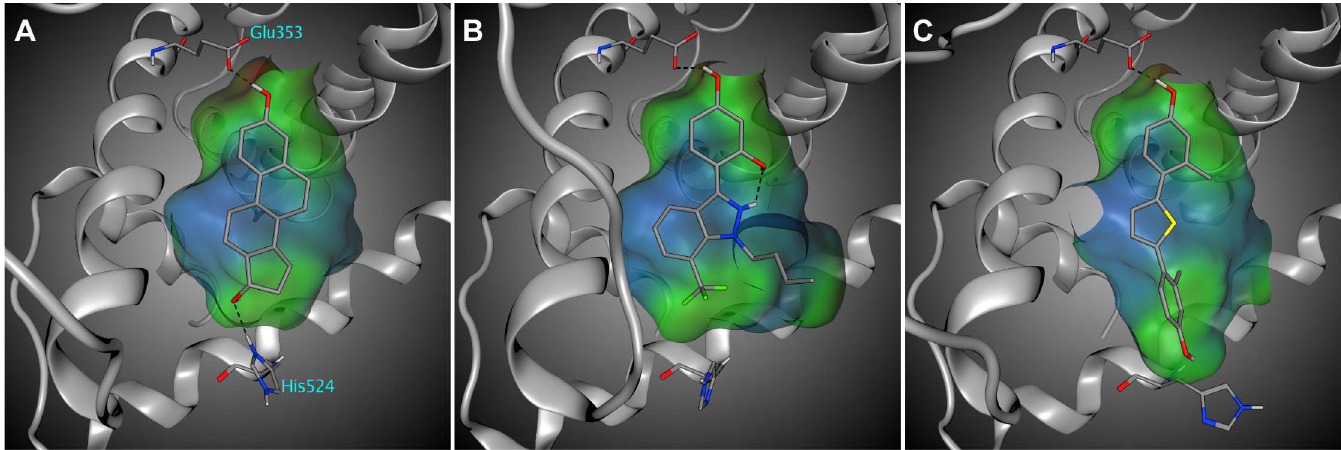
Fig 3. Classification of His524 conformations (PDB IDs: 2YJA, 4IVY, and 4IWC). Closed(A) and moved back (B) conformations which stabilizeprotein- ligandcomplex through hydrogenbondand hydrophobicinteraction, respectively. Open conformation (C) that provides an expanded bindingpocket for ligandslongerthan 13 Å . Ligandsare colored in orangewith hydrogen, oxygen, nitrogen, sulfur, and fluorineatoms in white, red, blue, yellow, and green,